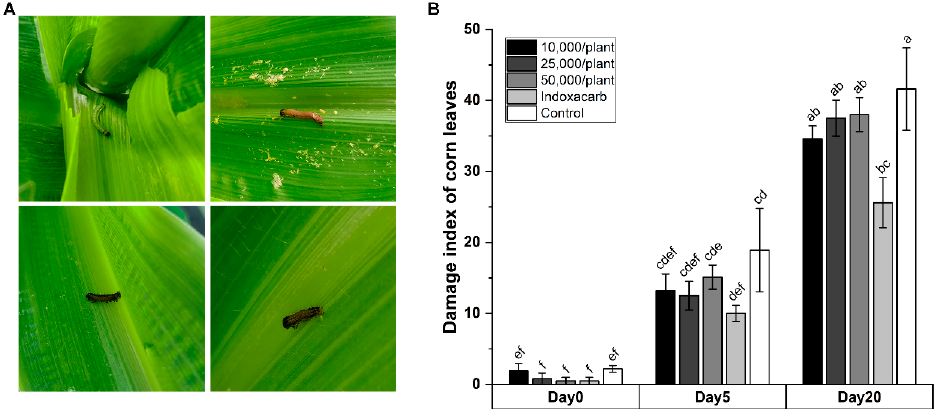
Figure 3. HbSD efficacy against S. frugiperda in field applications. ( A ) The alive (upper left corner) and dead larvae observed on corn leaves in field plots. ( B ) The damage index of corn leaves observed in field plots treated with HbSD suspensions, insecticide (specifically indoxacarb) and water. The significant differences are exhibited by lowercase letters ( p < 0.05) according to Tukey’s HSD tests.